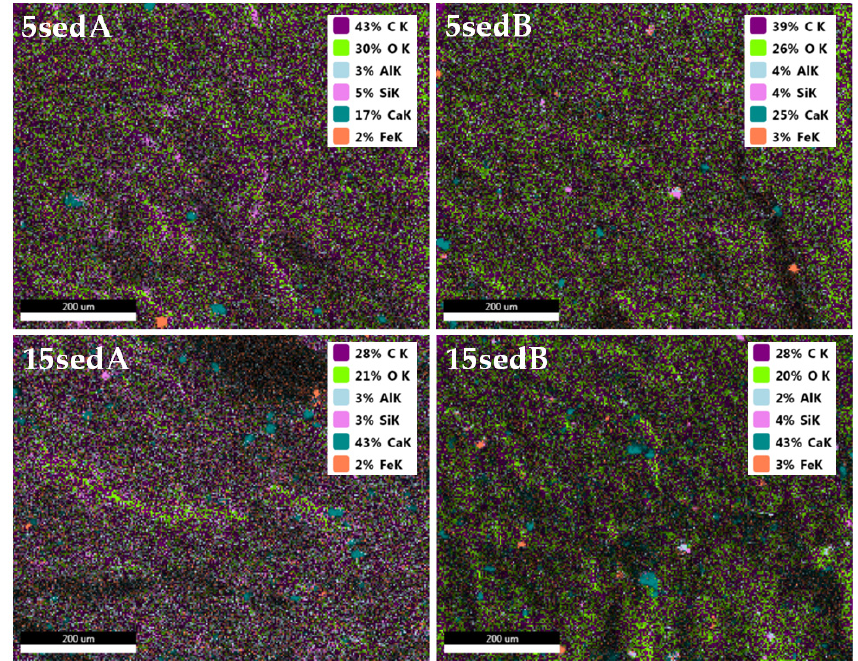
Figure 19. EDS of composites with the highest level of content.